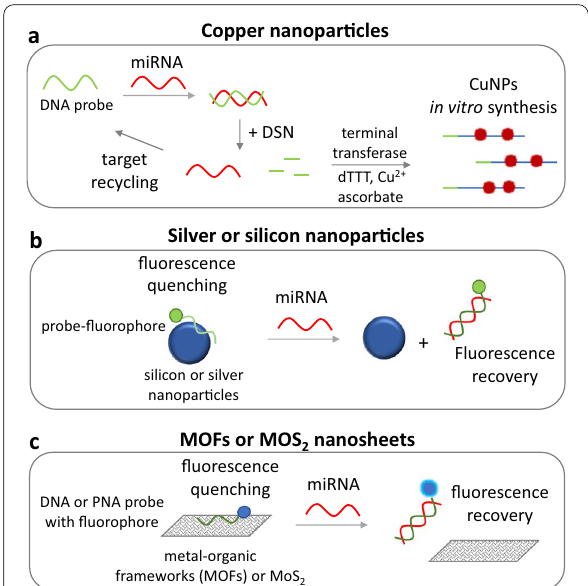
Fig. 5 a A fluorescent detection of miRNA based on the in